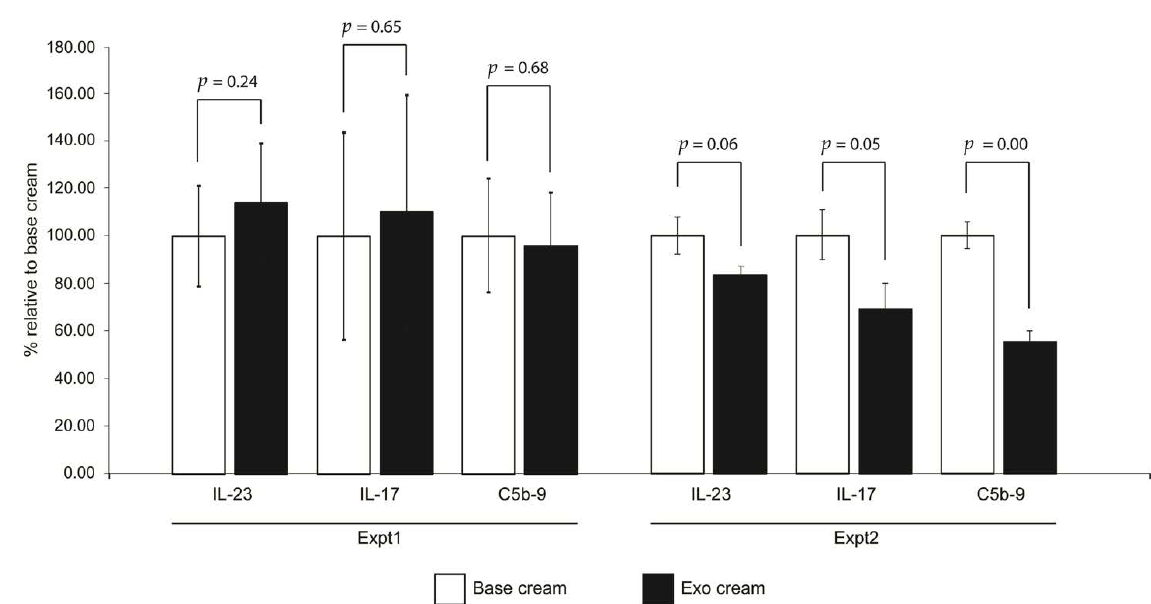
Figure 4. Cytokine induction and complement activation. The shaved back skin of each mouse was removed on day 6 (Expt. 1) or day 10 (Expt. 2), and assayed for IL-17, IL-23 and C5b-9 terminal complement complex (TCC). The levels of cytokines and TCC in “exo cream” (with MSC exsomes) was normalized to that of the “base cream” (vehicle control). Expt. 1 was performed with one independent animal experiment, and Expt. 2 was performed with two independent studies and combined. Statistical significance was determined by Student’s t test. p values < 0.05 were considered as statistically